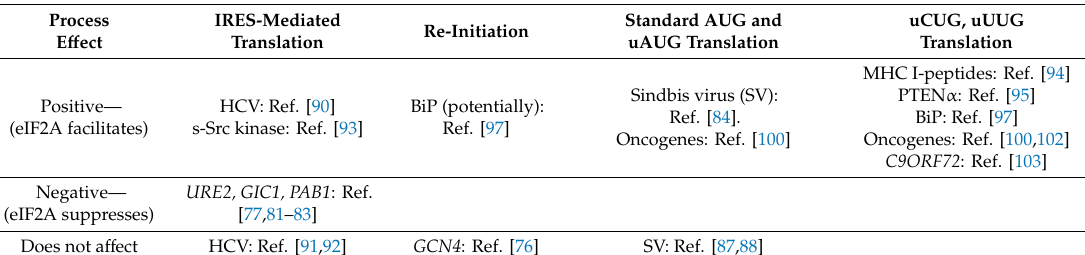
Table 4. eIF2A participation in initiation